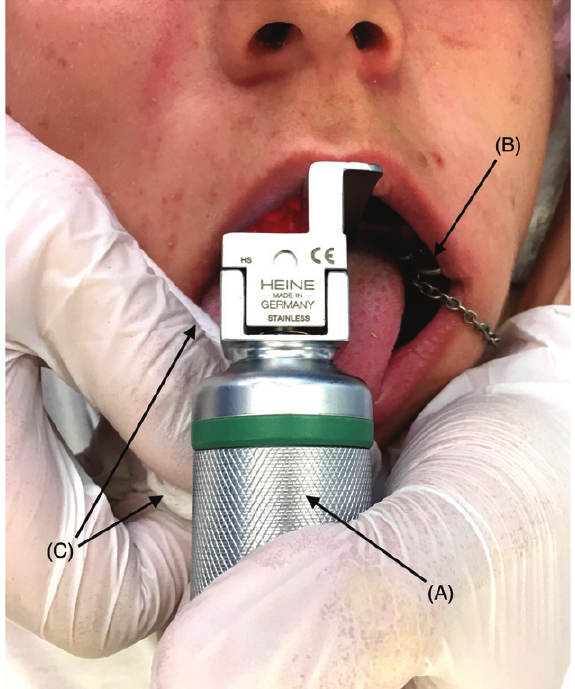
Figure 1. Usage of the ROMV technique during laryngoscopy. Note the wide opening of the mouth and the readily accessible area towards the posterior plate and the pharynx. A: Laryngoscope with size 3 Macintosh blade. B: Bite block applied to the left side of the mouth to maintain wide opening of the mouth, hence not requiring manipulation of the lower jaw. C: Gauze is used to grasp the tip of the tongue with the right hand and gently to pull it